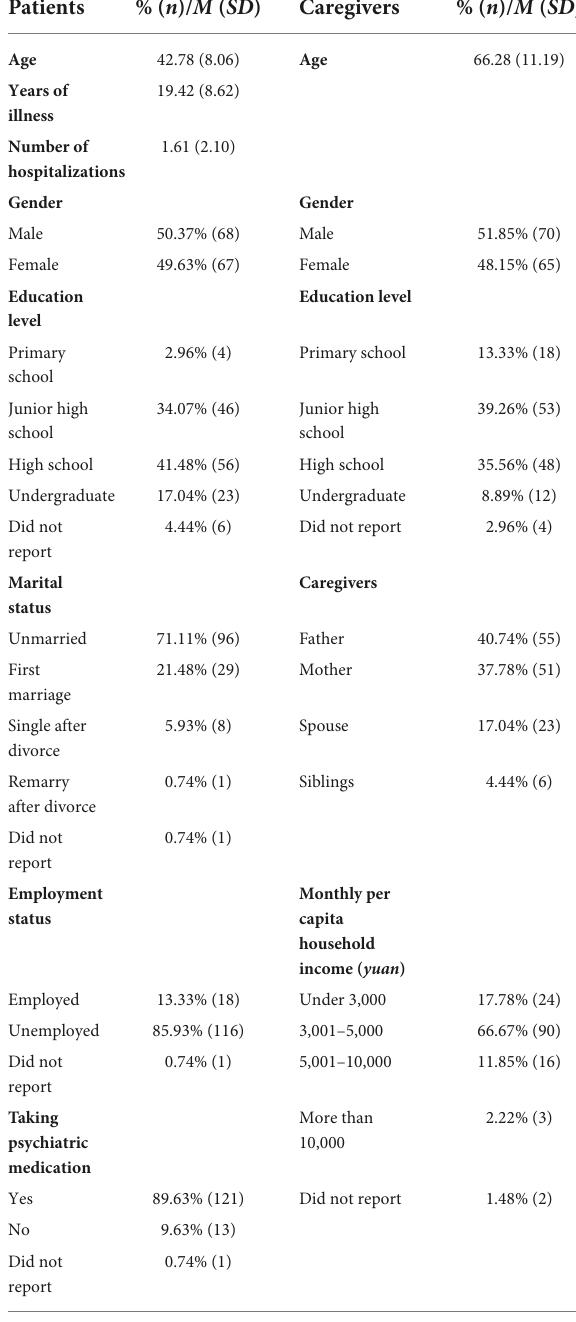
TABLE 1 Demographic information of patients ( N = 135) and their caregivers ( N =